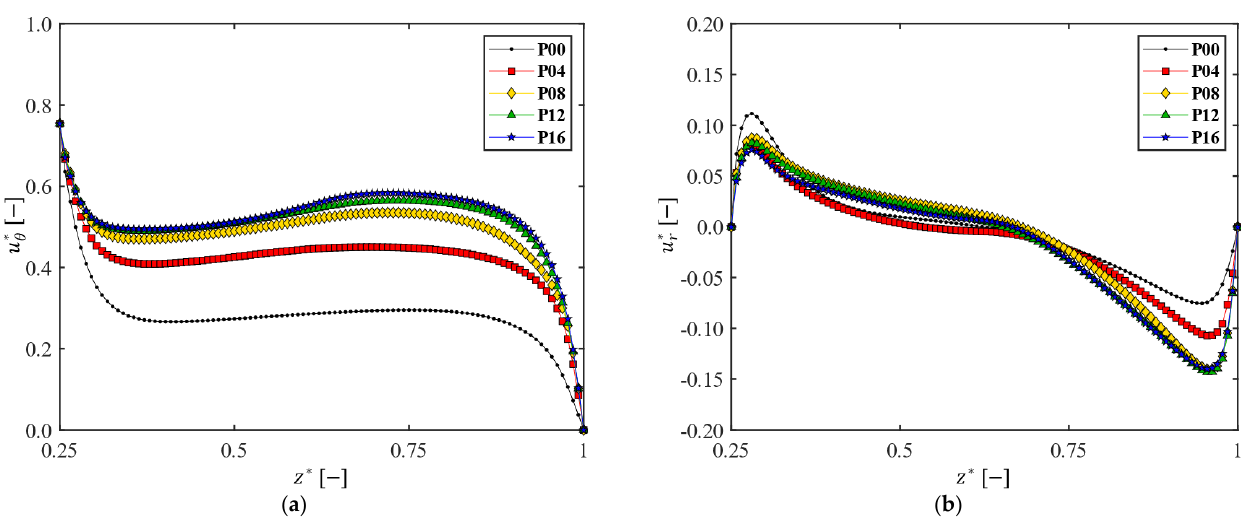
Figure 6. The influence of the number of patterns on the dimensionless circumferential and radial velocity profiles. The velocity profiles are measured at a location on the 𝑦 -axis with the radial distance 𝑟 ∗ = 0.75, when 𝛺 = 200 rpm. ( a ) Dimensionless circumferential velocity ( 𝑢 𝜃∗ ); ( b ) dimensionless radial velocity ( 𝑢 𝑟∗ ) .